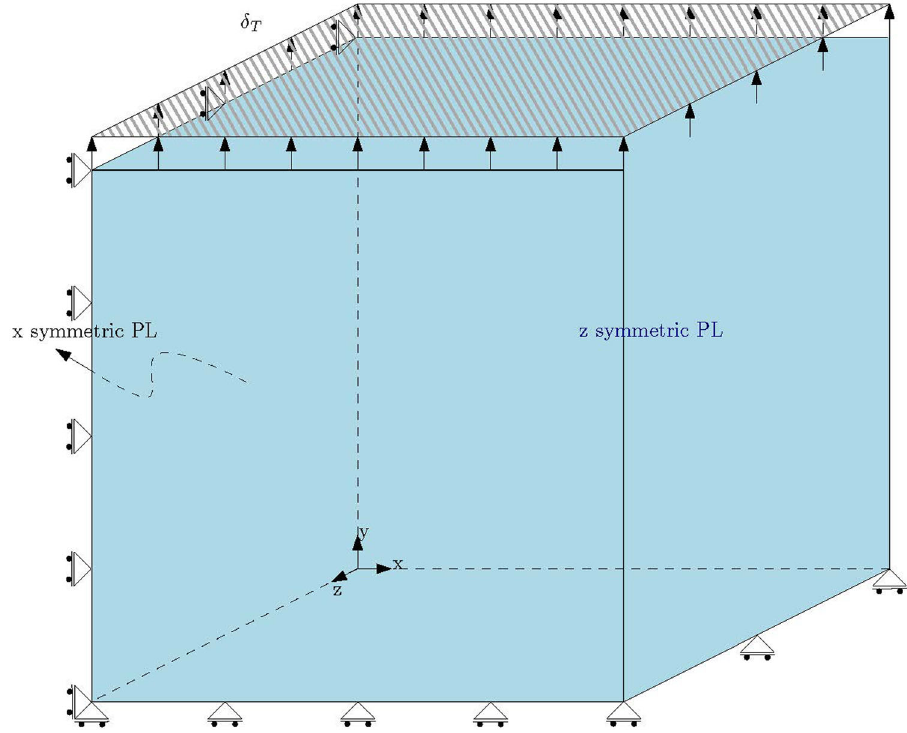
Fig. 6 Boundary and loading conditions for uniaxial tension test.